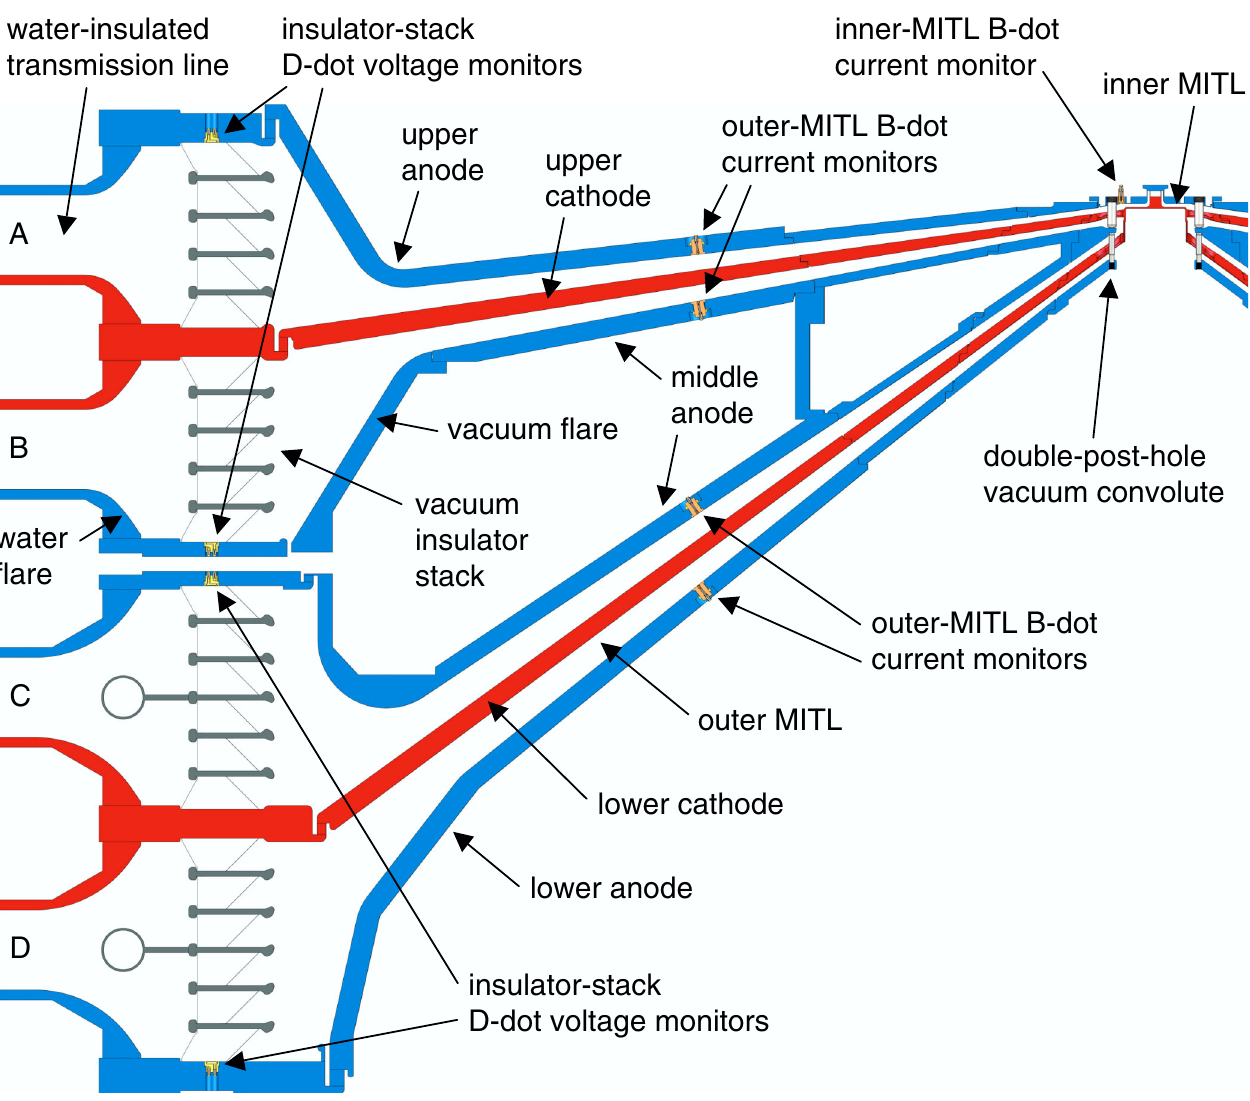
FIG. 2. (Color) Cross-sectional view of the insulator stack and magnetically insulated transmission lines (MITLs) of the Z pulsed- power accelerator [1,2,4–10]. This view shows the locations of the stack, outer-MITL, and inner-MITL